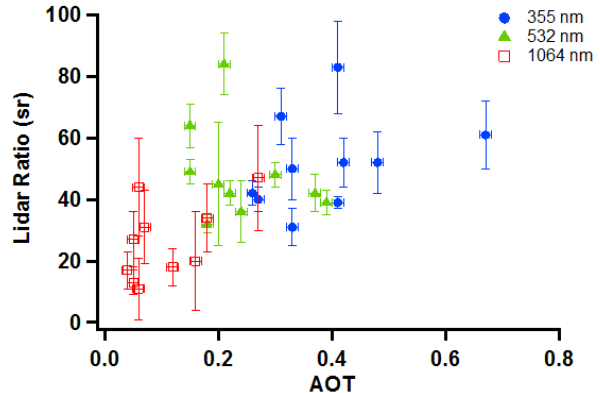
Fig. 13. Scatter plot of LRs at 355nm (dots), 532nm (triangles), and 1064nm (boxes) vs. the AOTs at 355nm, 532nm, and 1064nm,